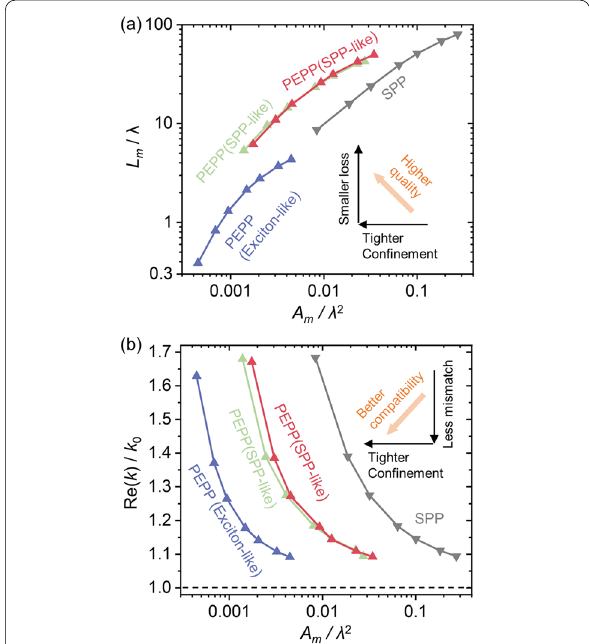
Fig. 6 Comparison between PEPPs and SPPs in parametric plots. a Normalized propagation length ( L m / λ ) versus normalized mode area ( A m / λ 2 ), revealing the trade-off between confinement and loss. Inset: since the confinement/propagation length increases toward the left/up direction, the trajectory located at the upper-left area indicates the best trade-off relation. b Normalized momentum (Re( k )/ k 0 , k 0 : wavevectors of free-space photons) versus normalized mode area ( A m / λ 2 ), revealing the trade-off between confinement and momentum mismatch to free-space photons (black dashed line). Inset: since the confinement/momentum mismatch increases toward the left/up direction, trajectories located at the bottom-left area indicate the best trade-off relation. Blue lines with triangles: exciton-like PEPPs for maximum confinement. Green and red lines with triangles: SPP-like PEPPs for maximum FOMs. Gray lines with triangles: